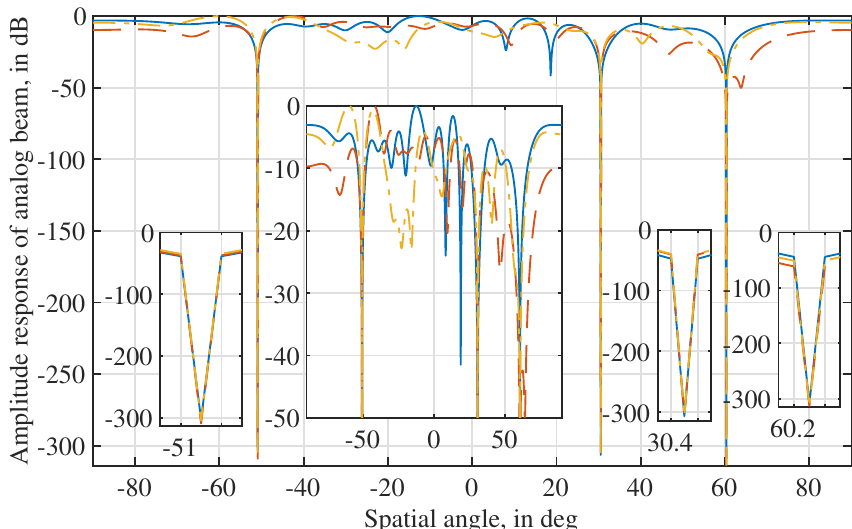
Figure 3. Illustrating the beams steered by the beamformers obtained in Figure 2.